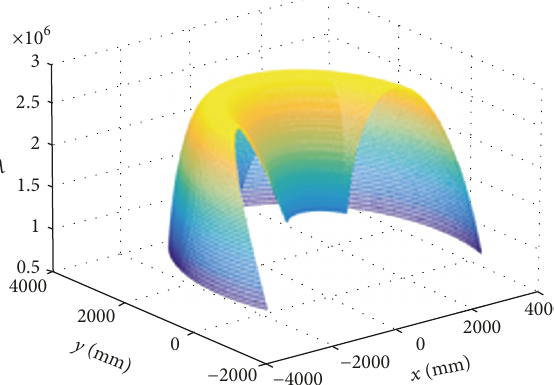
Figure 9: The dexterity analysis simulation of the